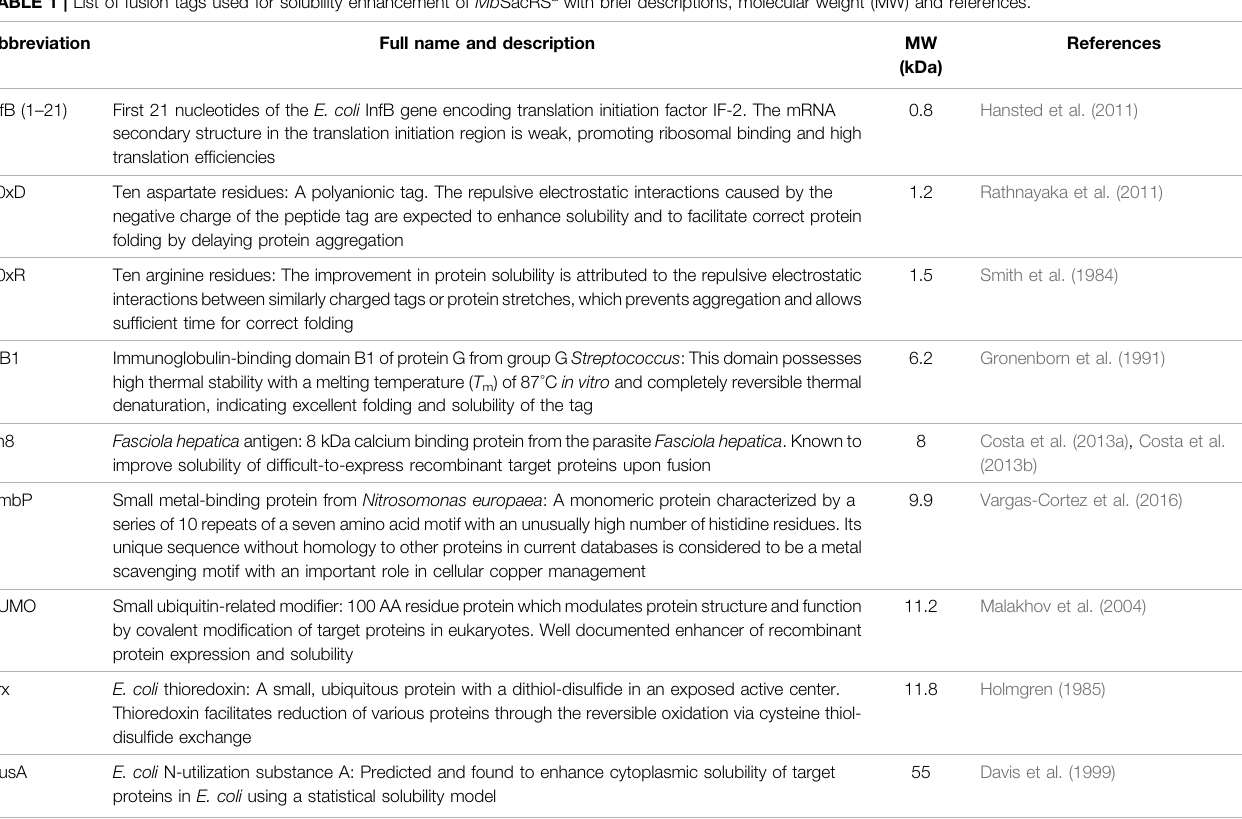
TABLE 1 | List of fusion tags used for solubility enhancement of Mb SacRS a with brief descriptions, molecular weight (MW) and references.